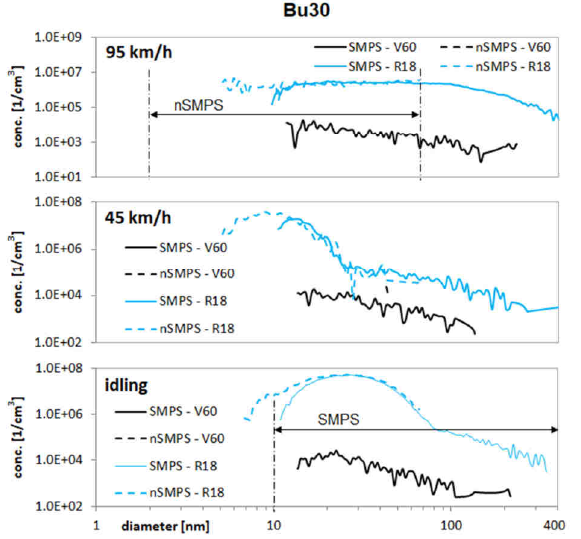
Fig. 9. Particle Size Distribution (PSD) during the SSC cycle. Comparison SMPS – nSMPS of two vehicles